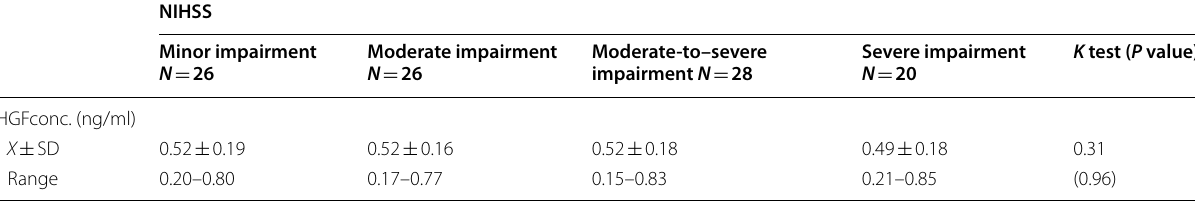
Table 13 The relation between HGF concentration and stroke severity assessed by NIHSS